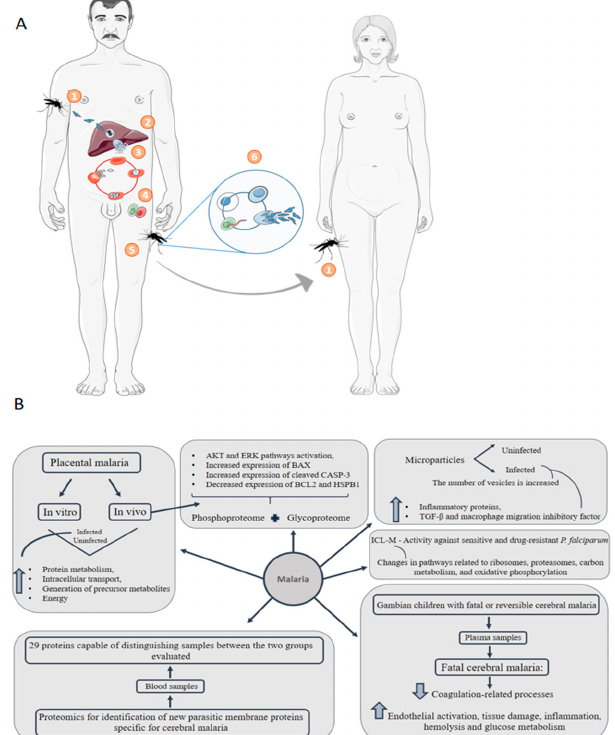
Figure 5. Malaria transmission cycle and representative proteomics-driven studies. ( A ) (1)